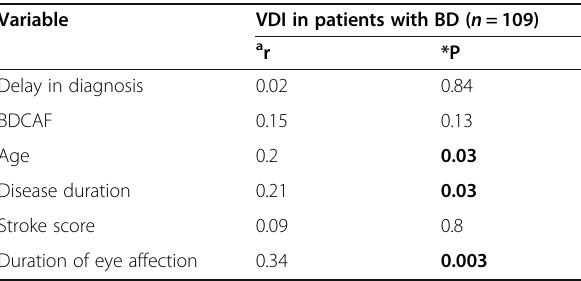
Table 5 Correlation of the Vasculitis Damage Index (VDI) score with some patients´ demographic and clinical variables